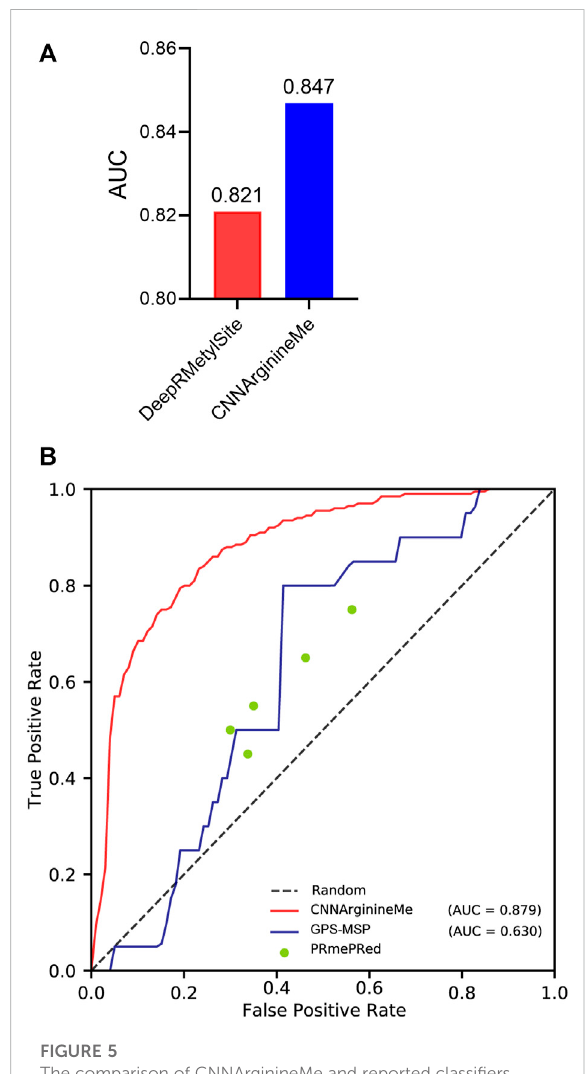
fold cross-validation and the independent test (Table 1 and Figure 3). The average AUC value and the Sn values of